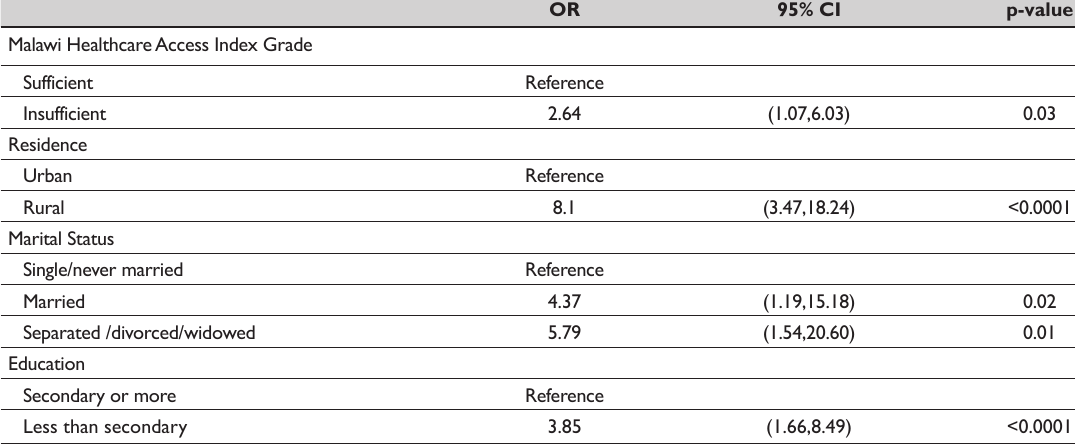
Table 3: Adjusted binomial logistic regression model estimates to quantify the likelihood of VVF (vesicovaginal fistula) using the Malawi Healthcare access index (MHAI) as predictive marker of the association between VVF and MHAI with perineal tear used as the reference group